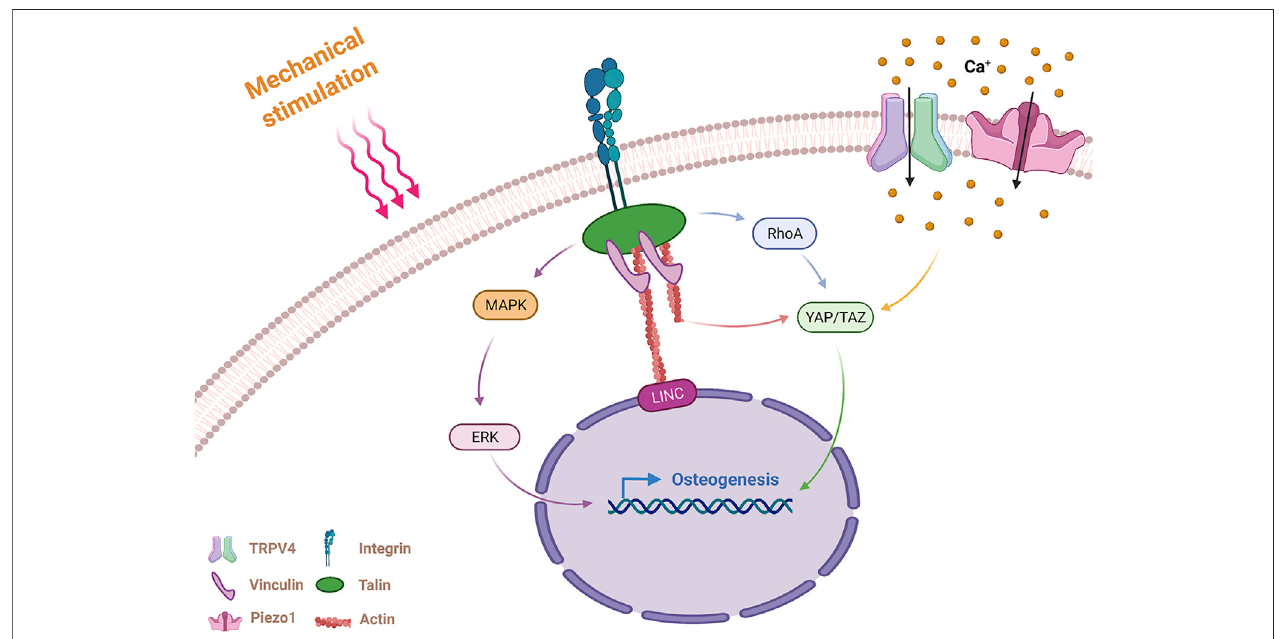
FIGURE 1 | Mechanism of MSCs sensing and responding to mechanical stimulation. MSCs sense external mechanical stimulation via integrins and mechanosensitive ion channels and transmit the mechanical signals via actin stress fi bers and molecular pathways. Integrins activate RhoA, MAPK pathways, and actin fi bers by FAs (including vinculin and talin) in response to mechanical stimulation. MAPK promotes osteogenesis through nuclear localization of ERK. The RhoA pathway and actin fi bers promote osteogenesis through nuclear localization of YAP/TAZ. The mechanosensitive ion channels TRPV4 and Piezo1 generate an intracellular Ca 2+ in fl ux after sensing mechanical stimulation, and Piezo1 promote osteogenic differentiation through nuclear localization of YAP/TAZ. MSCs, mesenchymal stem cells; RhoA, Ras homolog gene family, member A; MAPK, Mitogen-activated protein kinases; FA, focal adhesion; ERK, extracellular signal-regulated kinase; YAP/TAZ, Yes-associated protein/transcriptional coactivator with PDZ-binding motif; TRPV4, transient receptor potential vanilloid